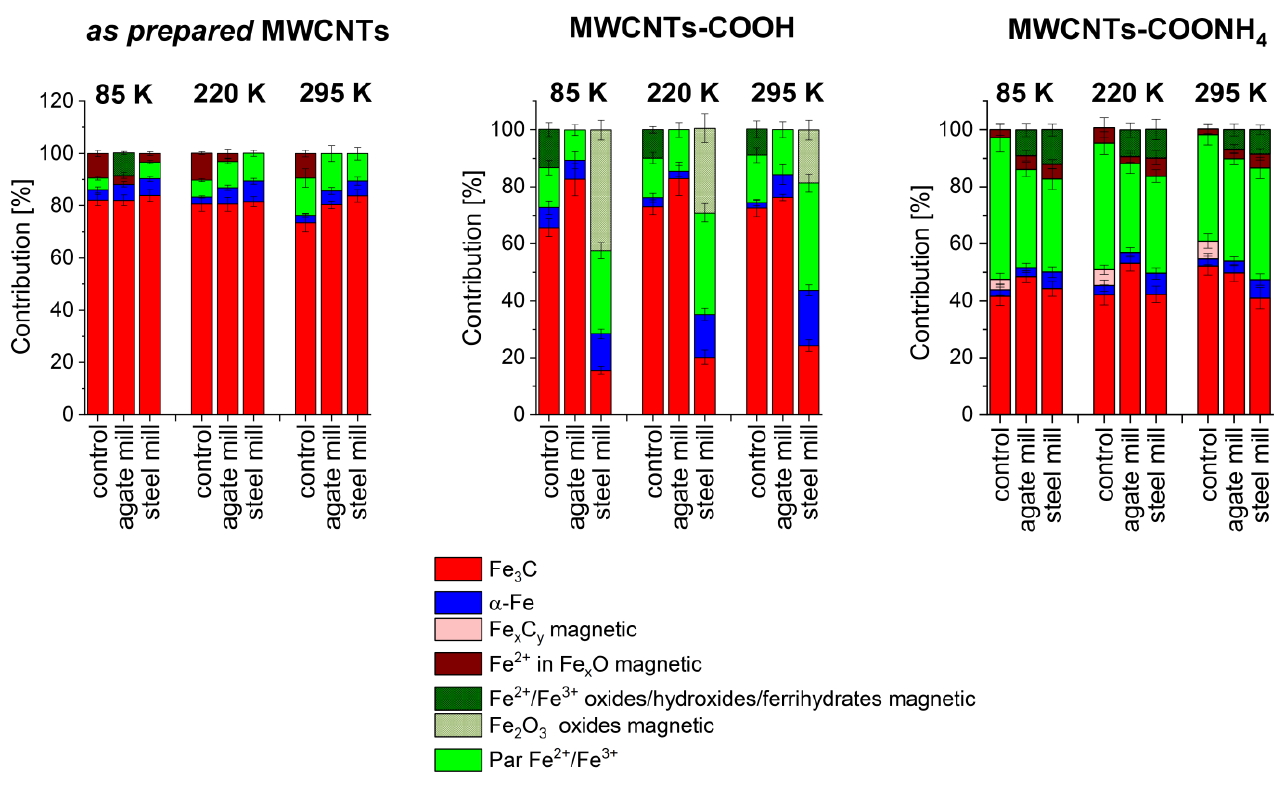
Figure 3. Contributions of iron phases in non-functionalized and functionalized MWCNTs ground in the agate and steel mill.